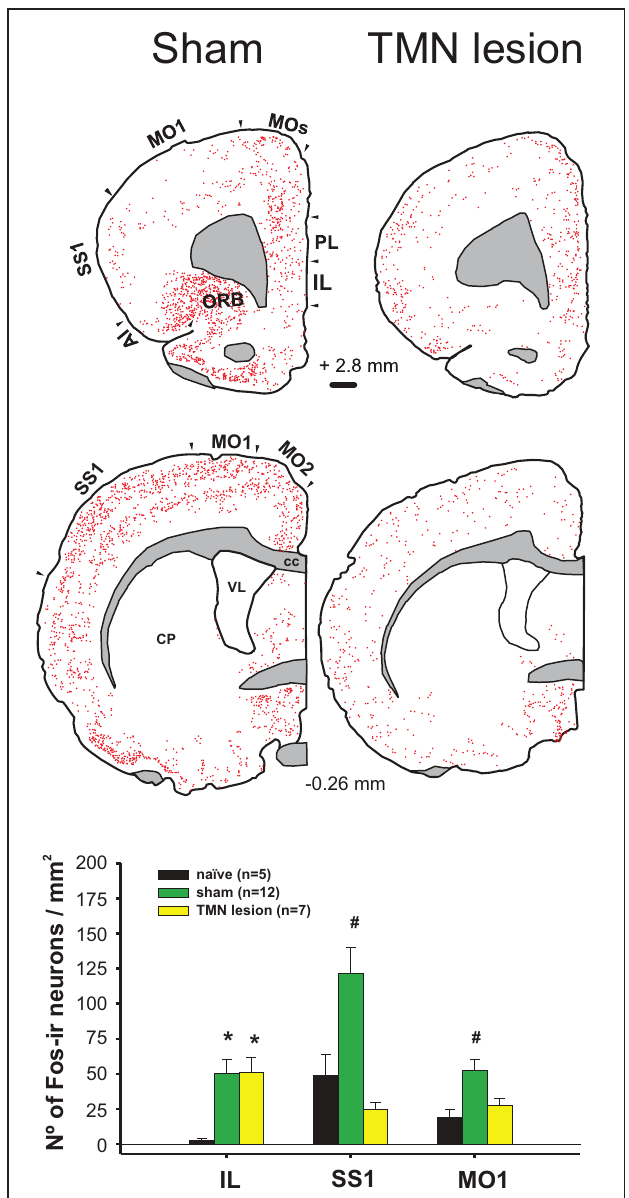
FIGURE 3 | Enticing intact (sham) hungry rats with food strongly activated the frontal cortex (left column). This activation was impaired by a TMN lesion (right column), except for the IL. Lower graph compares the activation of three cortices in the sham and TMN lesioned rats. The naïve group corresponded to the circadian control, i.e., to rats fed ad libitum , not enticed and sacrificed at the same time during the day as the other groups (Valdes et al., 2006).